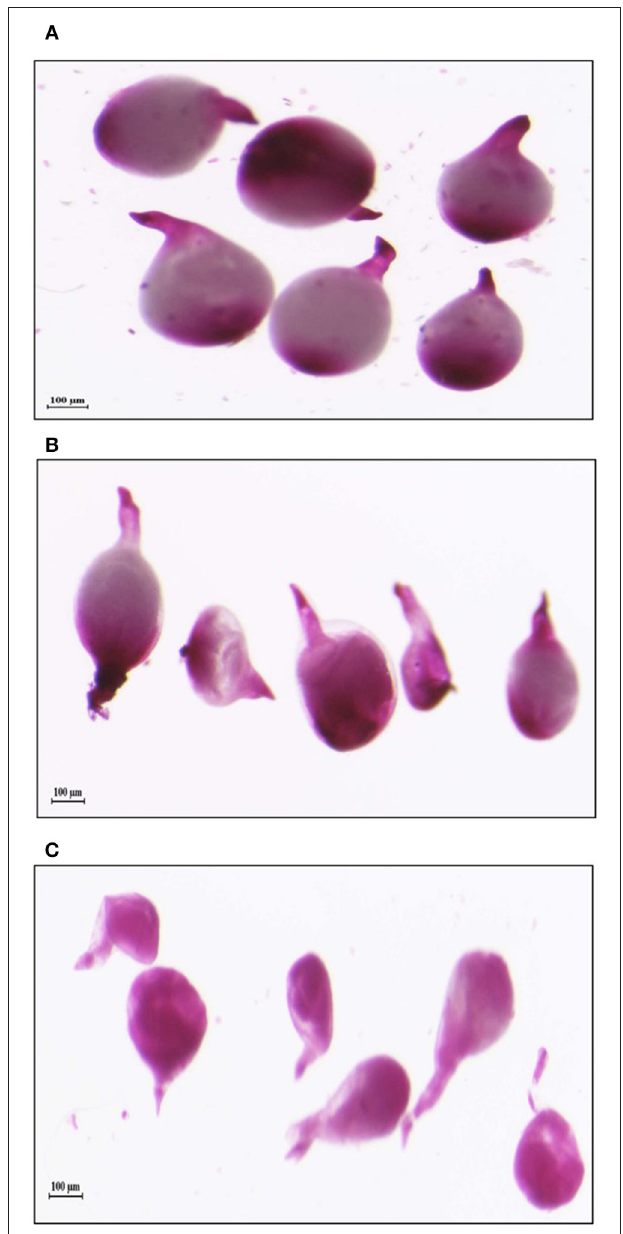
FIGURE 9 | Deformation in the shape of mature females isolated from tomato plants expressing dsRNAs of (B) Mi-col-1 and (C) Lemmi-5 as compared to the healthy females isolated from (A) Wild type, 35 days post